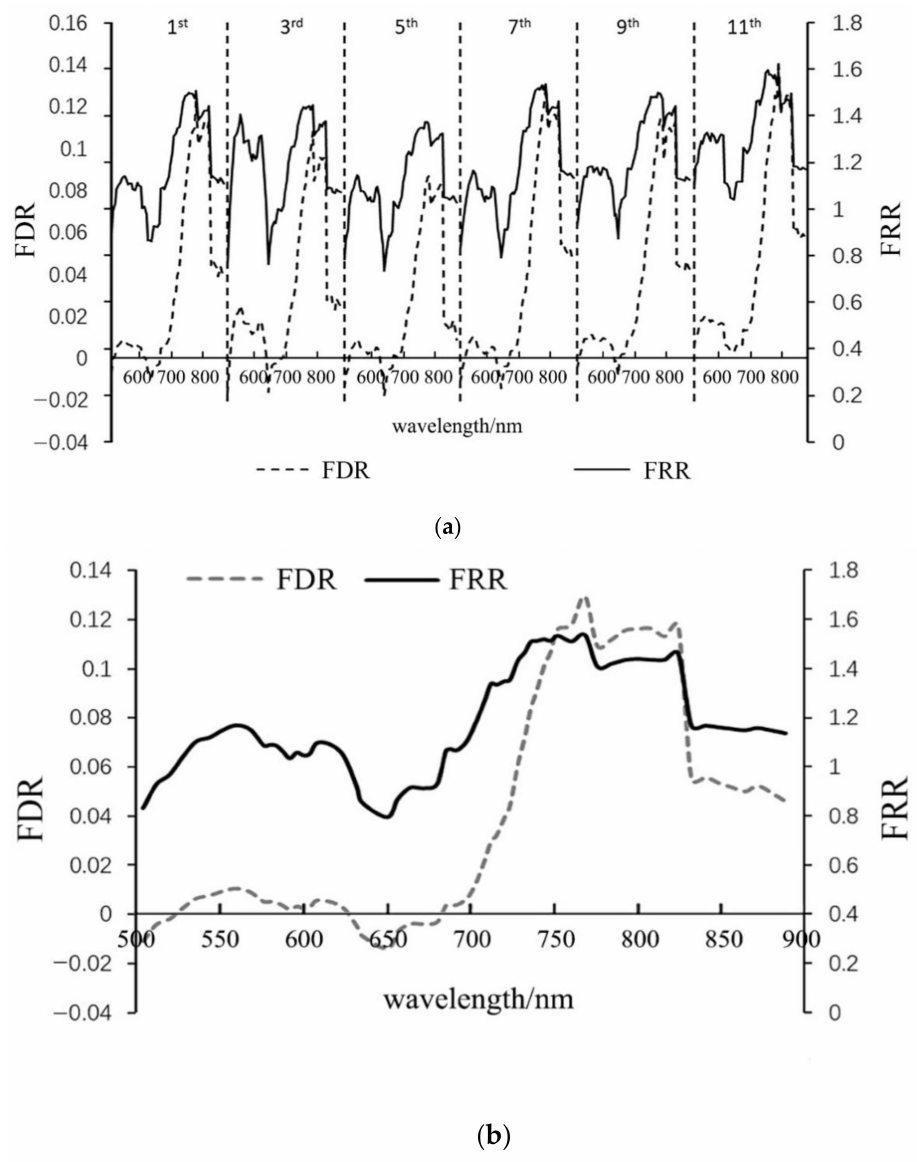
Figure 3. ( a ) Time series florescence difference reflectance and florescence ratio reflectance (from 1st day to 11th day) ( b ) florescence difference reflectance and florescence ratio reflectance at the 7th day of the flowering